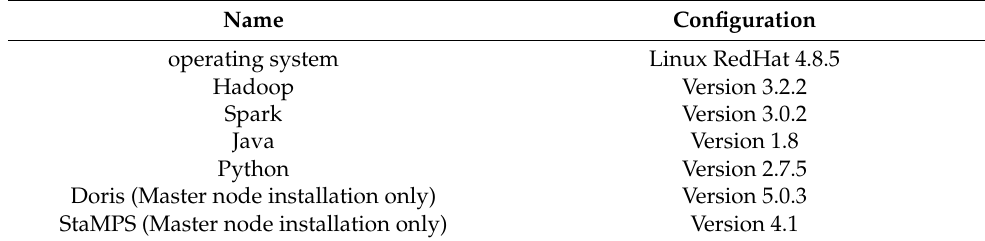
Table 1. YARN cluster software configuration information.